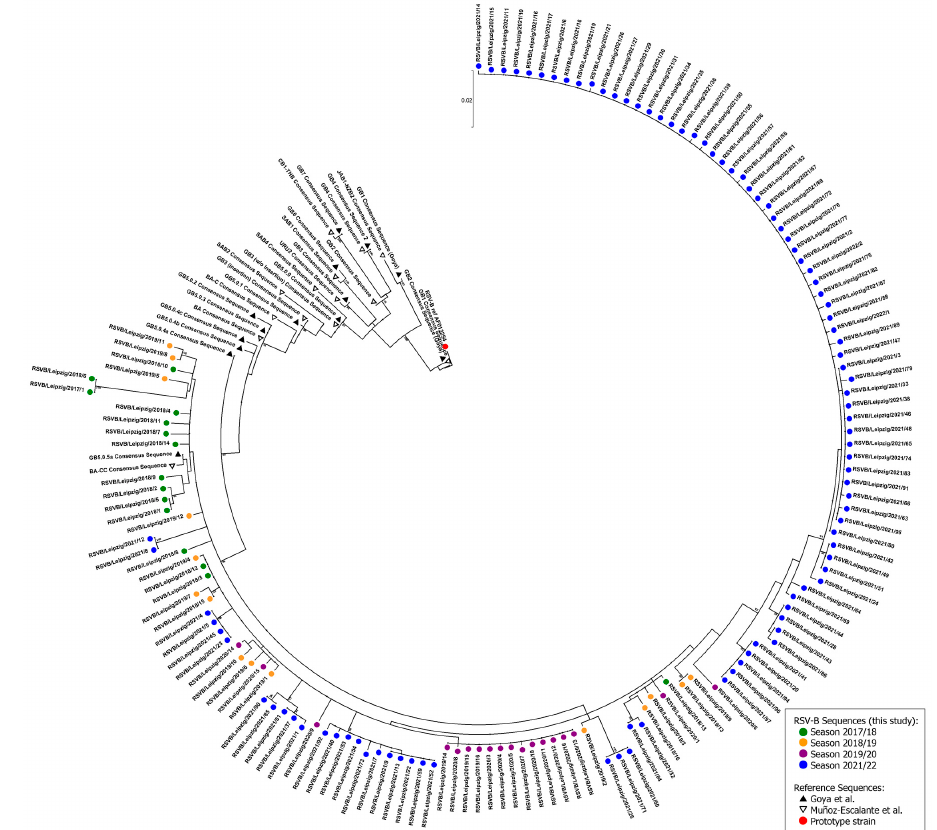
Figure 5. Molecular phylogenetic analysis of the RSV-B G gene by maximum likelihood method. The evolutionary history was inferred by using the maximum likelihood method based on the Tamura– Nei model [24]. The tree with the highest log likelihood ( − 4492.48) is shown. Initial tree(s) for the heuristic search were obtained automatically by applying neighbor-joining and BioNJ algorithms to a matrix of pairwise distances estimated using the maximum composite likelihood (MCL) approach, and then selecting the topology with superior log likelihood value. The tree is drawn to scale, with branch lengths measured in the number of substitutions per site. The analysis involved 173 nucleotide sequences. There were a total of 939 positions in the final dataset. Evolutionary analyses were conducted in MEGA7 [23]. Only nodes with a statistical support >80% are shown. The symbols indicate the sequence origin or the season of the indicated strain (dots: red, RSV-B reference strain; green: season 2017/2018 isolates; orange, season 2018/2019 isolates; purple, season 2019/2020 isolates; blue, season 2021/2022 isolates; black triangle: consensus reference sequences according to Goya et al. [14]; white triangle, consensus reference sequences according to Muñoz-Escalante et al. [15]).